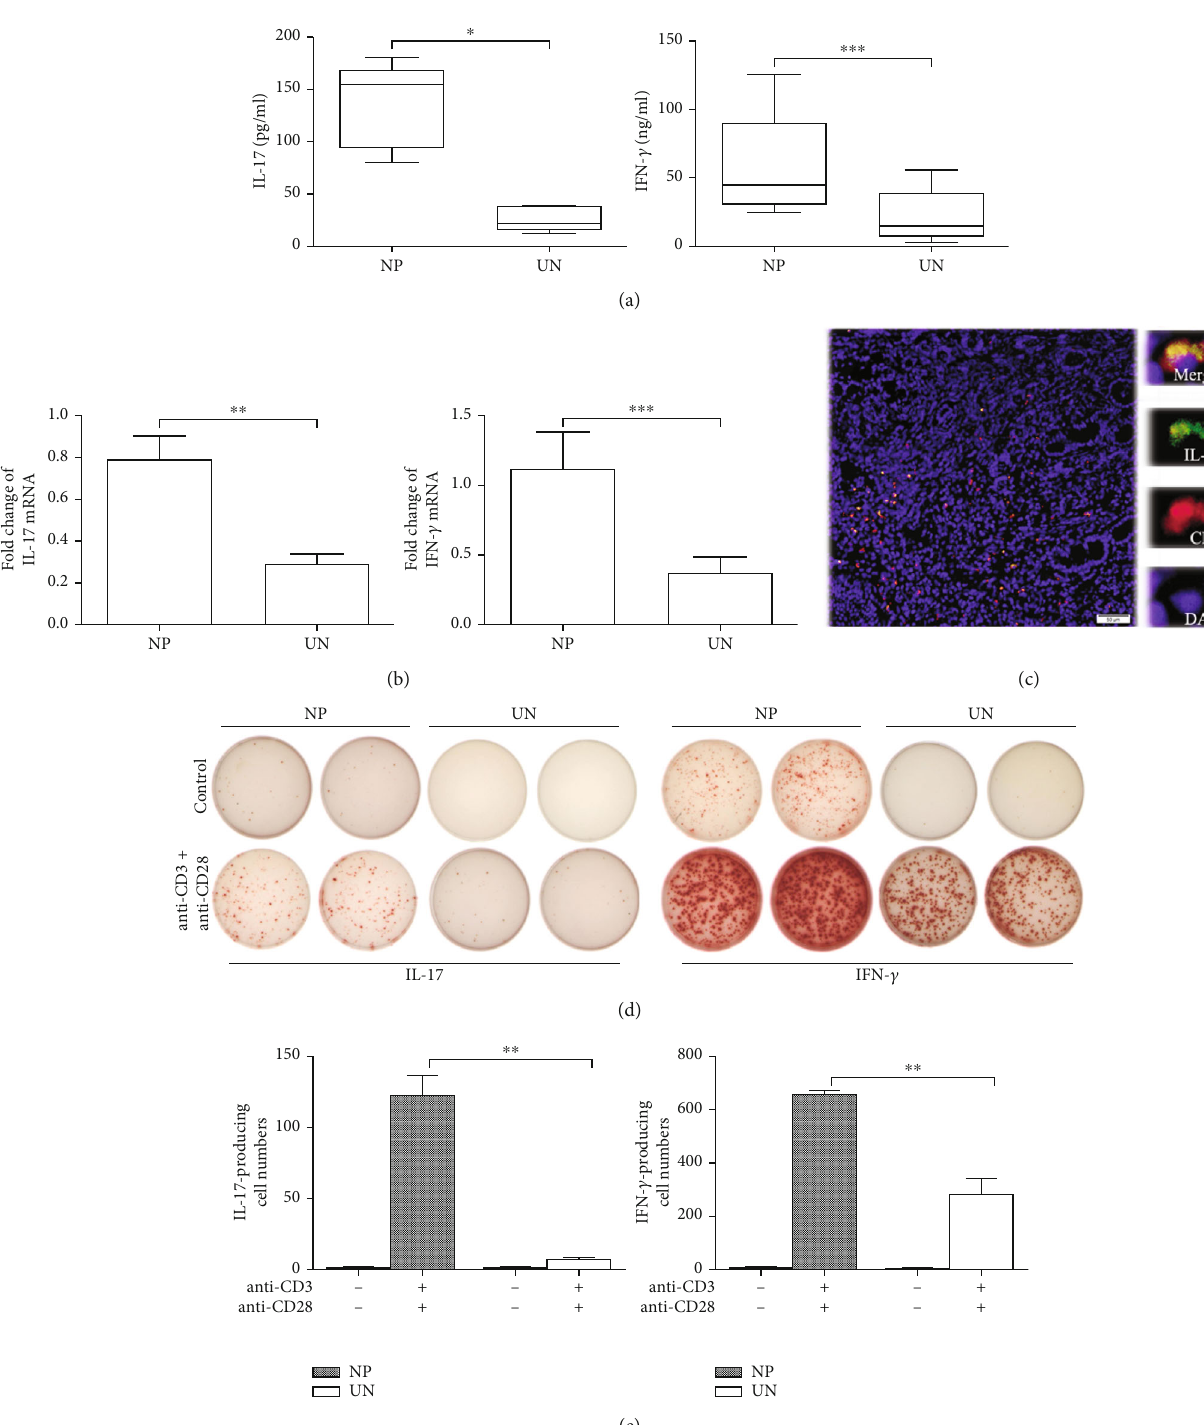
Figure 1: Increased IL-17A in NP tissues. (a) Summary data showed the concentrations of IL-17A and IFN- γ in the homogenates of NP ( n = 18 ) and uncinate ( n = 10 ) tissues. (b) Summary data showed mRNA expression of IL-17A and IFN- γ in NP ( n = 18 ) and uncinate ( n = 10 ) tissues. (c) Representative microphotographs of CD3 (red)-, IL-17 (green)-, and DAPI (blue)-stained section of NP tissues. Scale bars represent 50 mM. (d) The mononuclear cells from NP and uncinate tissues were cultured with or without anti-CD3 plus anti-CD28 for 24h. Representative ELISpot results of IL-17A- and IFN- γ -producing cells were shown. (e) Summary ELISpot results of IL-17A- and IFN- γ -producing cells were shown ( n = 5 ). Data were shown as the mean ± SEM . Statistical signi fi cance was determined with the Mann – Whitney test. ∗ p < 0 : 05 ; ∗∗ p < 0 : 01 ; ns: no signi fi cance; NP: nasal polyp; UN: